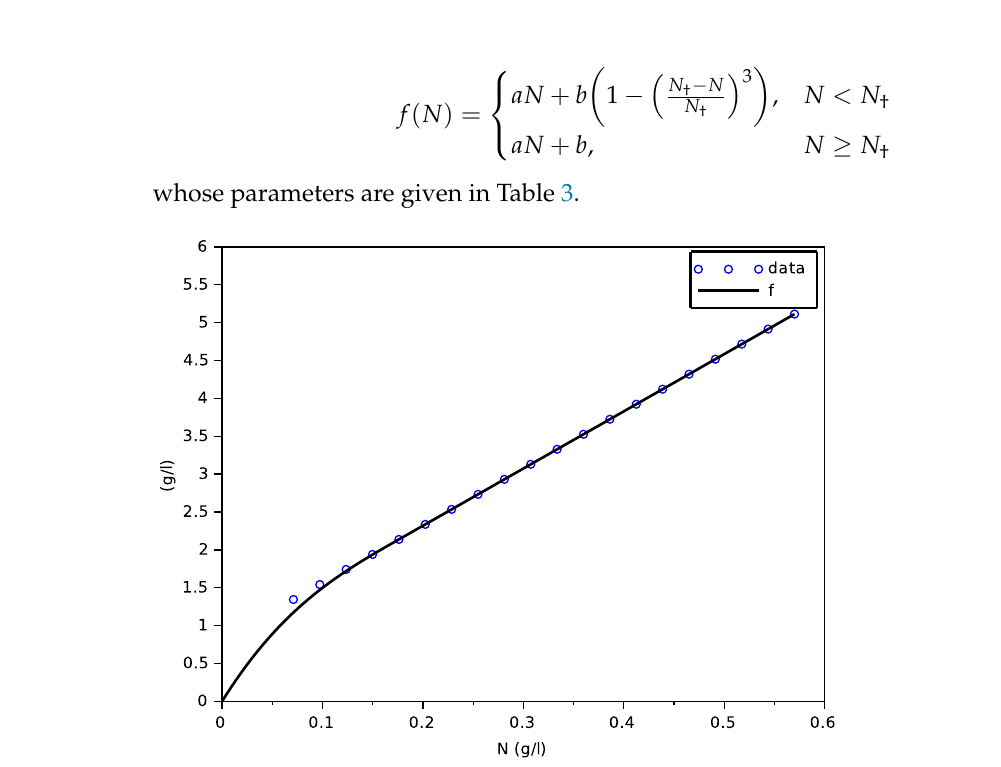
Figure 2. Result of the fitting of the function f on data from the model with transporters. The calibration of the parameters a , b of the function f was performed with a linear regression (function reglin of scilab ). Table 3. Parameters of the variable yield function y